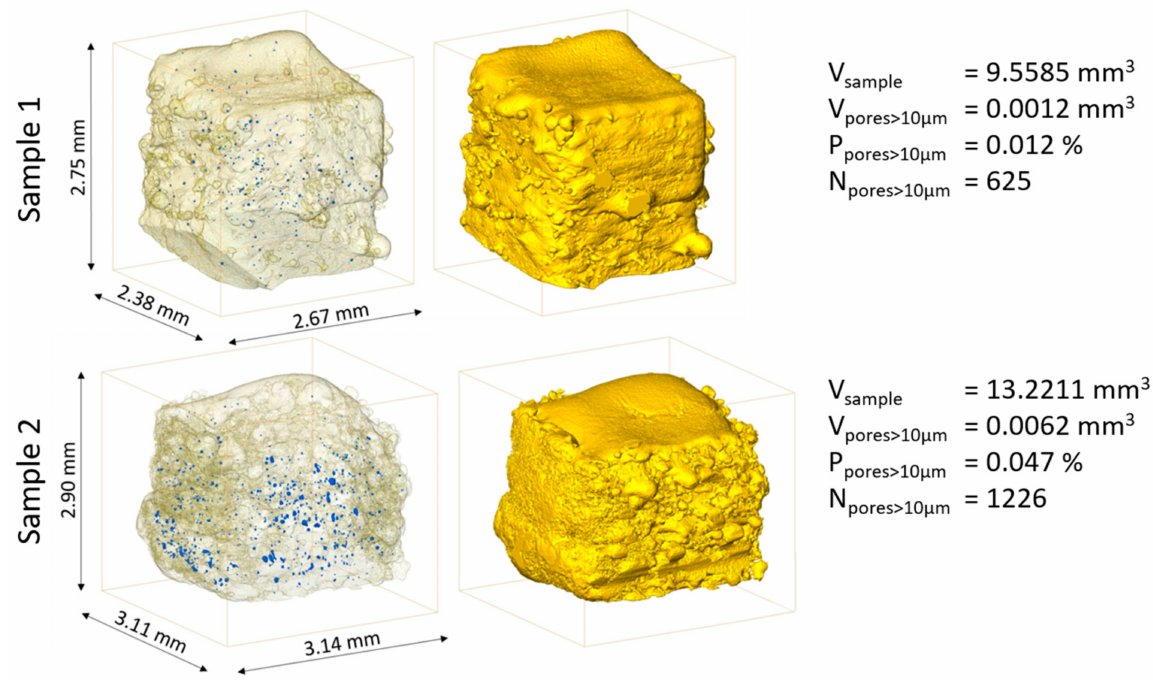
Figure 1. 3D renderings of the L-PBF-printed red-gold samples revealing sample shapes and their closed porosities in blue. For each sample, the number of pores >10 µ m (all pores which are larger than 10 µ m) and their volume relative to the total sample volume has been